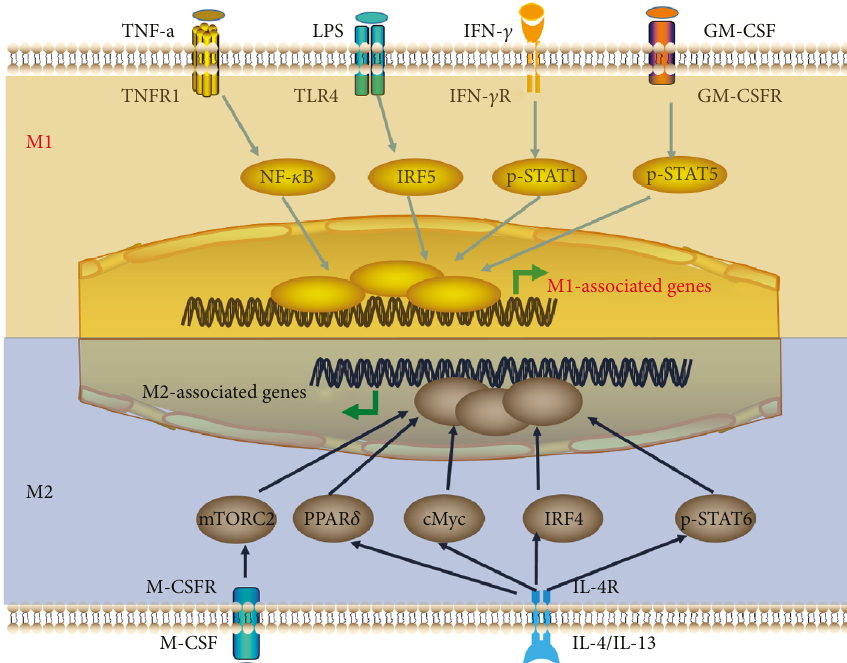
Figure 1: Mechanisms underlying macrophage polarization. The major signaling pathways contributing to the generation of M1 and M2 subsets are outlined. M1 macrophages are polarized following stimulation with IFN- γ , LPS, TNF- α , and GM-CSF and engagement of TLR4. A predominance of NF- κ B, IRF5, STAT1, and STAT5 activation promotes M1 macrophage polarization. In contrast,